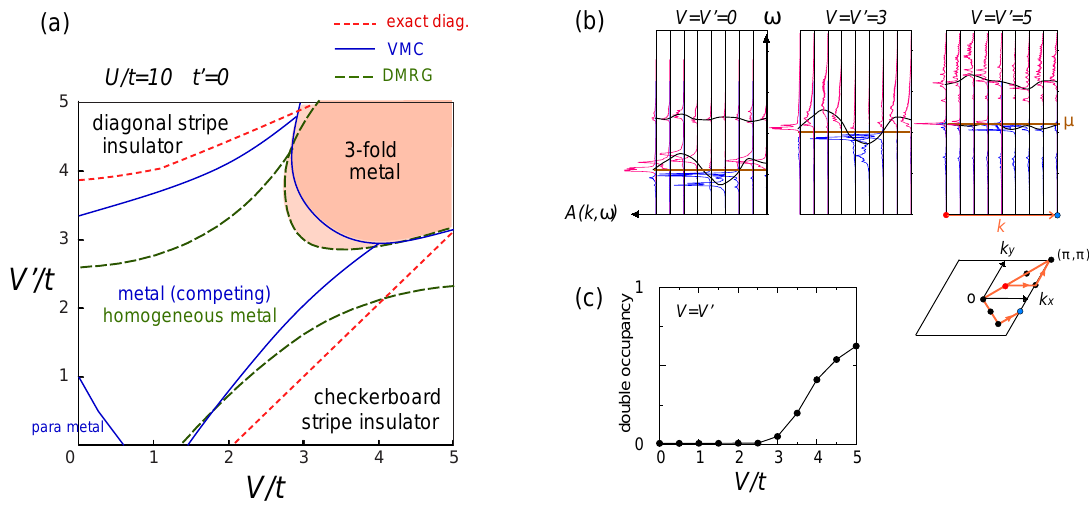
Figure 10. Numerical results of the 3/4-filled extended Hubbard model on the anisotropic triangular lattice. ( a ) Phase diagrams obtained by the exact diagonalization ( N = 4 × 4 , Merino et al .) [32], VMC ( N ∼ 400 , Watanabe et al .) [33], and DMRG ( N = 8 × 6 , Nishimoto et al .) [34], put together on the plane of V and V (cid:48) with U/t = 10 and t (cid:48) = 0 . Adapted with permission, copyrighted by the American Physical Society ([32,34]) and the Physical Society of Japan ([33]); ( b ) Single-particle spectrum A ( k, ω ) by the exact diagonalization and ( c ) double occupancy of the charge-rich sublattice at V = V (cid:48) (DMRG), adapted with permission from [34], copyrighted by the American Physical